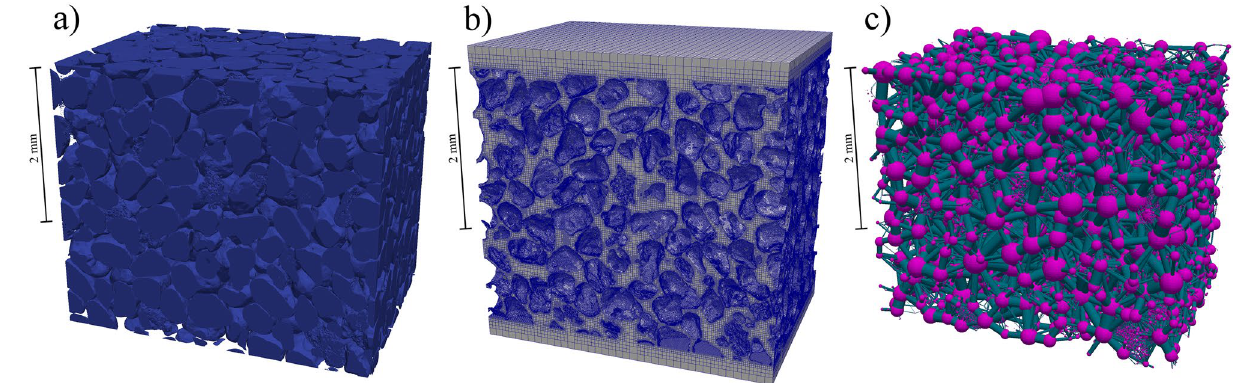
Figure 10. Different approaches to pore space representation: (a) triangulated pore space-solid boundary, the result of XRT scan, (b) numerical mesh spreading pore network, aligned to real pore space geometry, and c) simplified pore network representation by the pore network model. All three visualizations are based on sample 1d (figure created using Paraview 5.3 software https ://www.parav